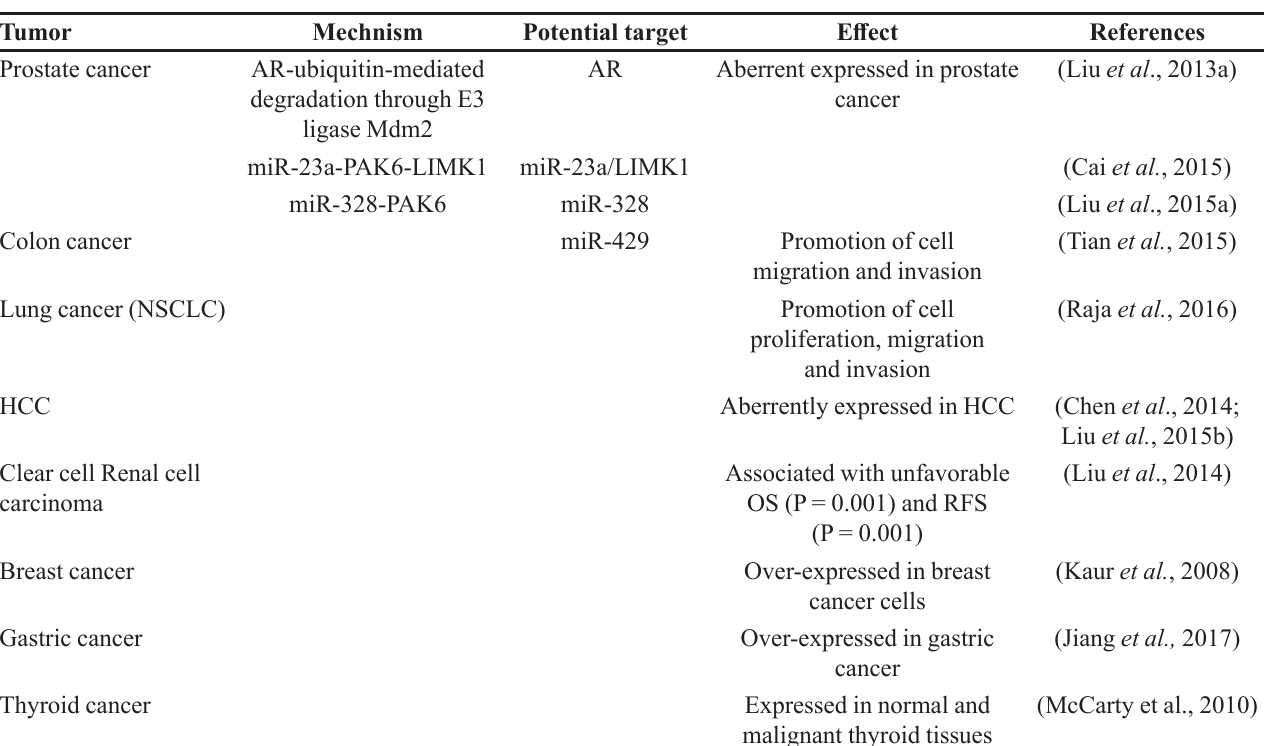
NSCLC: non-small cell lung cancer AKT: protein kinase B HCC: hepatocellular carcinoma OS: overall survival RFS: recurrence- free